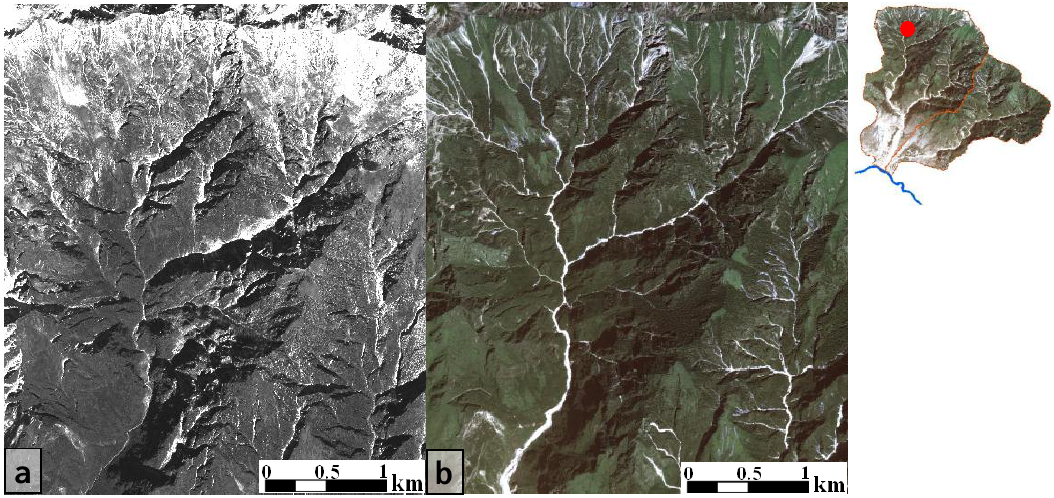
Fig. 4. Imagery showing the debris flow development in the initiation area of the Sanyangyu basin by comparison of imagery prior to and after the rainstorm event ( a : Worldview image taken on 16 May 2010 prior to the event; b : Quickbird image taken on 15 August 2010 after the event).